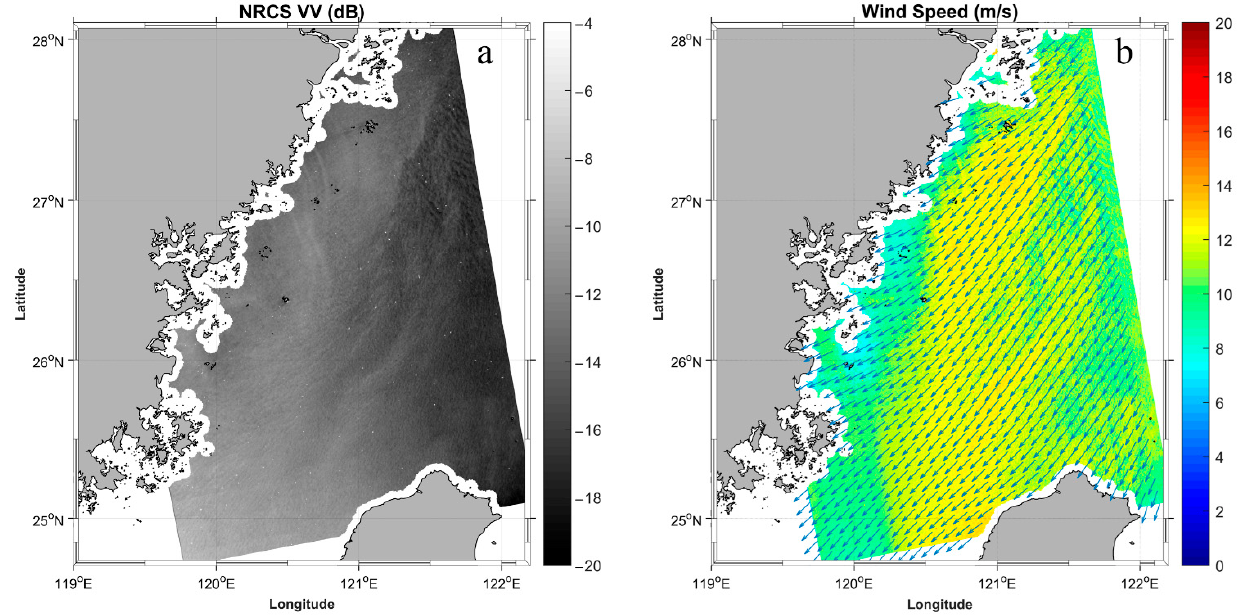
Figure 9. ( a ) Sentinel-1 C-band SAR image in VV polarization that was acquired from the ascending pass at 10:02 UTC on 12 January 2020, given by the greyscale values (in dB); ( b ) wind speeds retrieved by the OPEN model, with the color bar denoting the wind speeds (m/s).